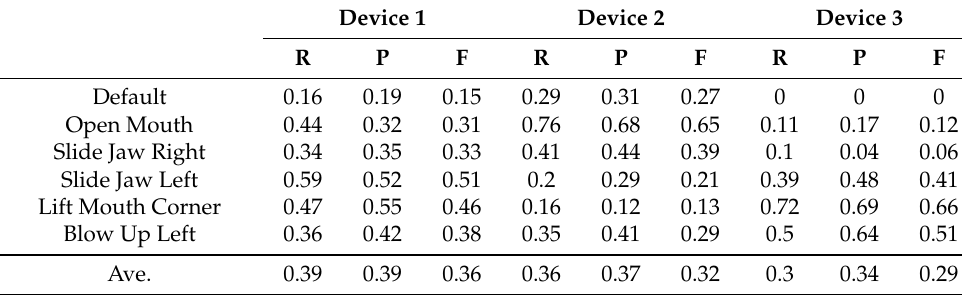
Table A5. The results of a single device for each gesture in Evaluation 3.